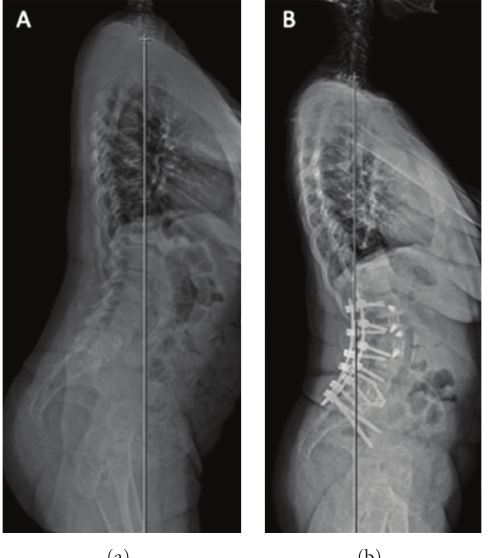
Figure 3: (a) Pre- and (b) postoperative standing 36 inch lateral radiographs demonstrating improvement in sagittal vertical axis after two-level ALR plus multilevel MIS LIF with open posterior instrumentation.